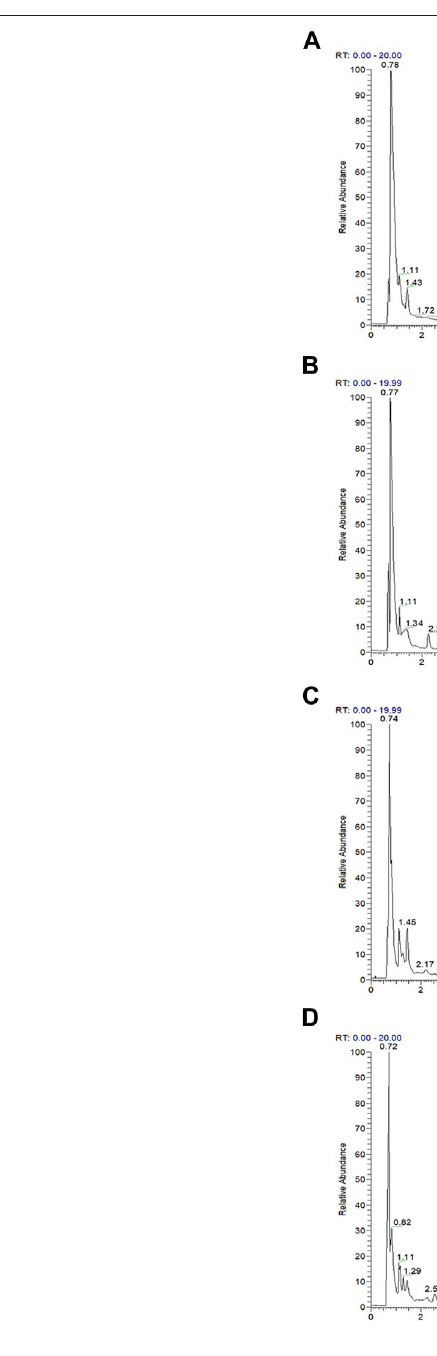
Frontiers in Bioengineering and Biotechnology |